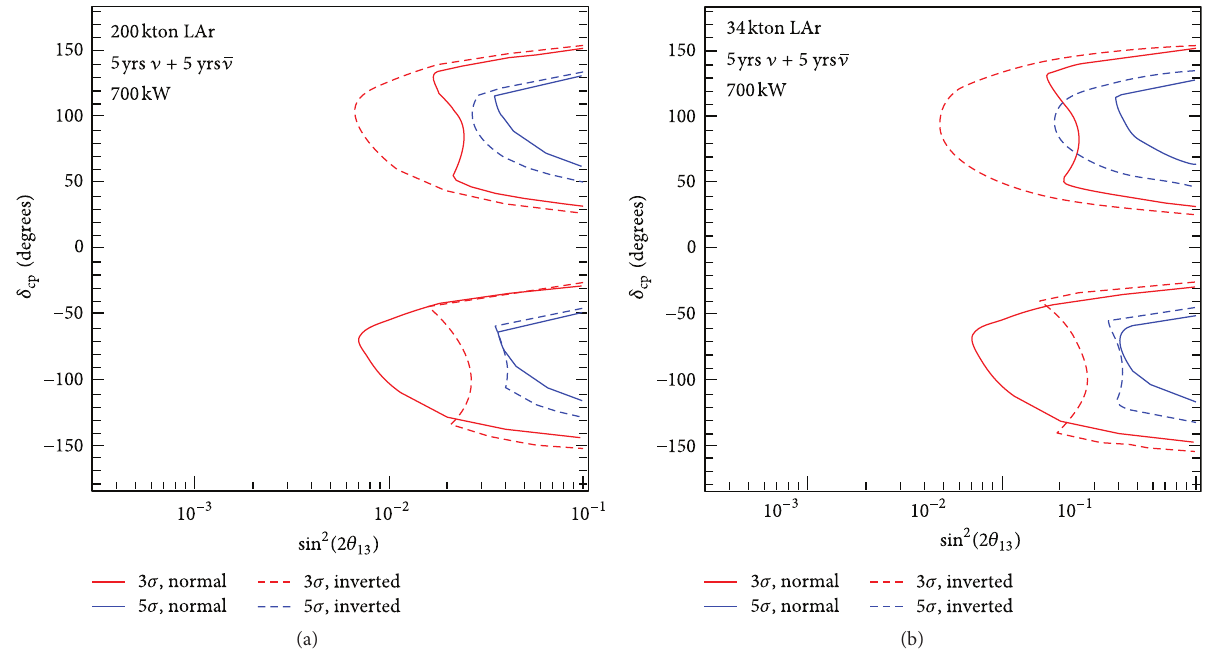
Figure 9: LBNE sensitivity to CPV at 3𝜎 (red curves) and 5𝜎 (blue curves) for 5 years of running in the neutrino channel plus 5 in the antineutrino one. A 200kton WC (a) or a 34 kton LAr (b) are used in a 700 kW beam. Figure is taken from